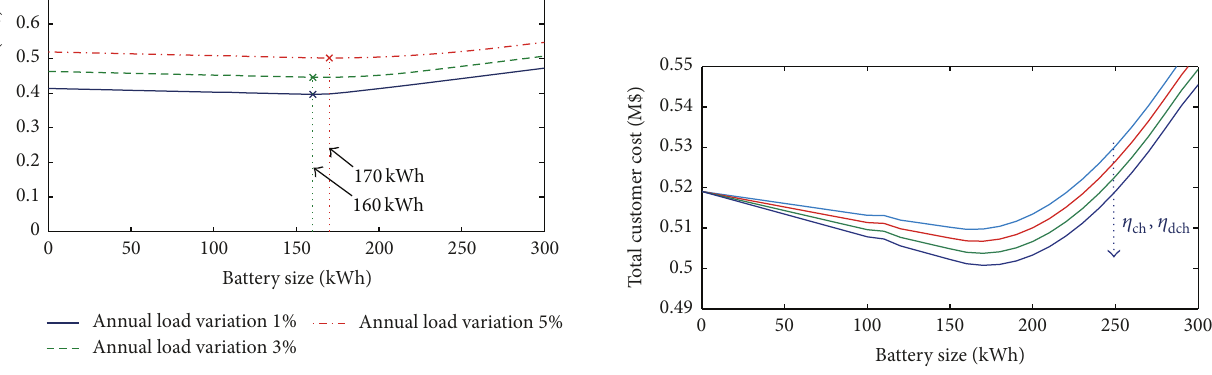
Figure 3: Total customer cost with 𝛼 = 5 %, 𝛽 = 5 %, 𝜂 = 98 % for different values of annual load variation (residential 𝜂 dch load).